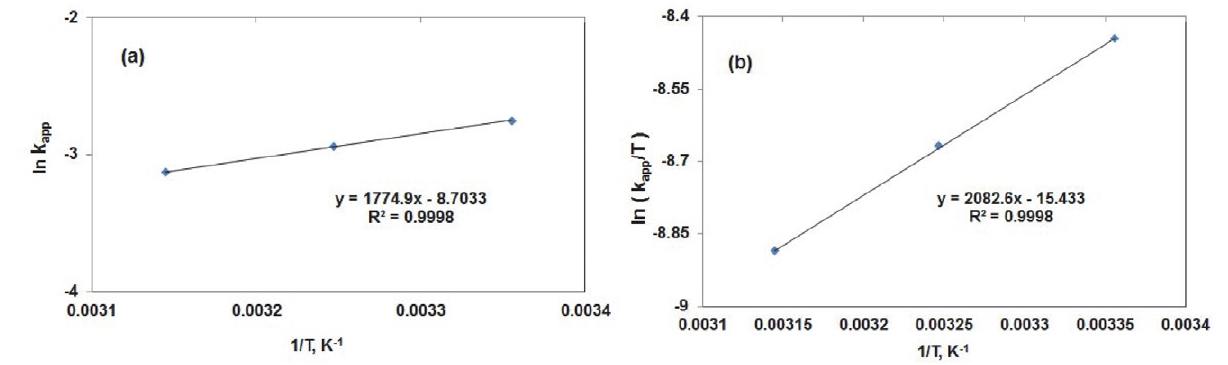
Fig. 12. (a) Arrhenius plot of lnk app against 1/T (b) ln(K app /T) versus